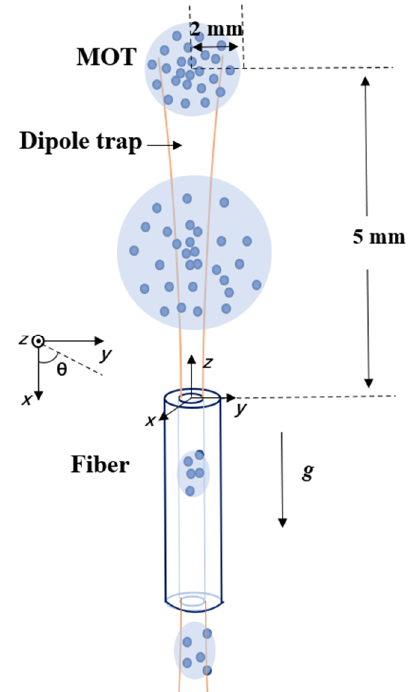
Figure 1. Configuration of the model for the simulation. The magneto-optical trap (MOT) has a radius of 2 mm, and the atomic cloud expands when released from the MOT.